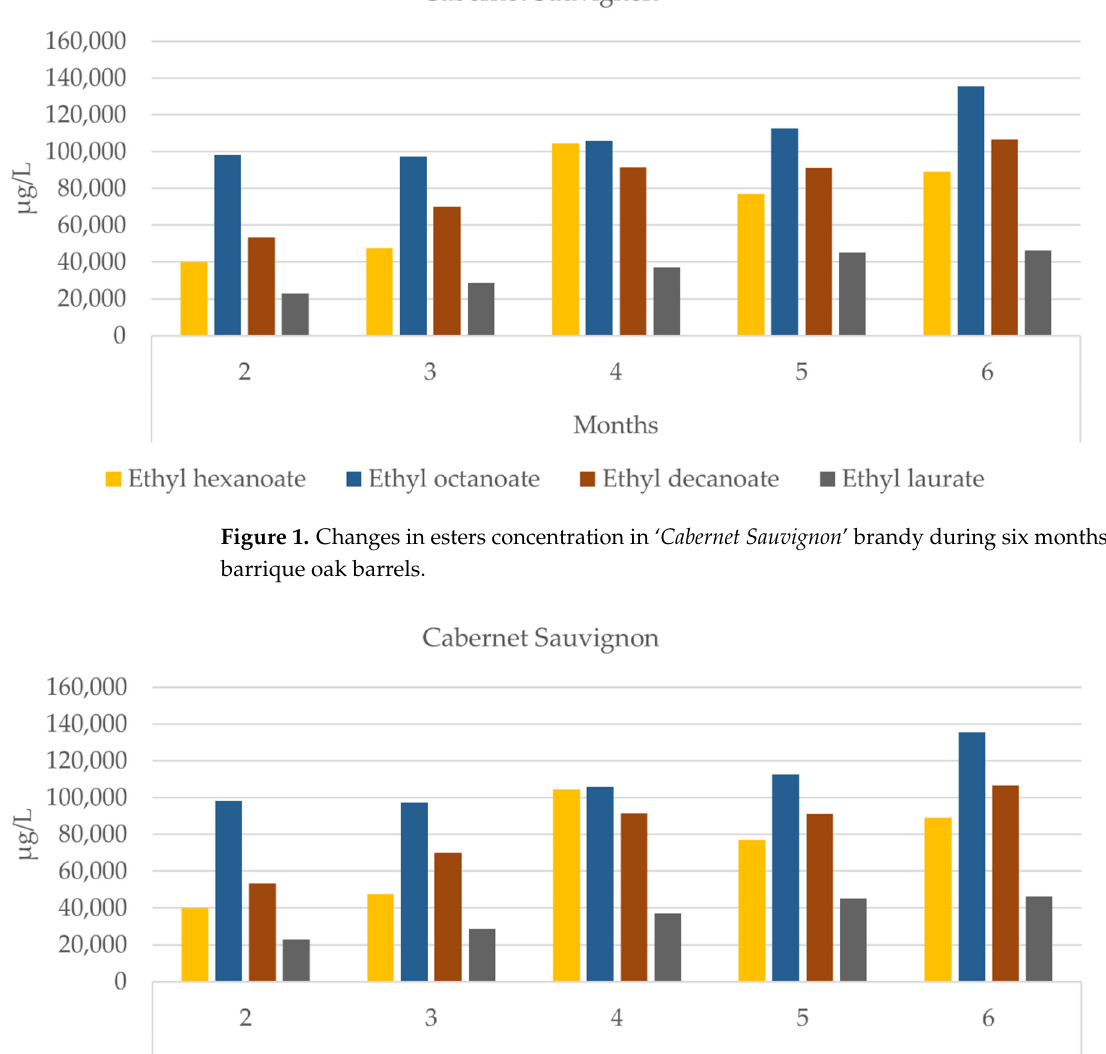
Figure 2. Changes in esters concentration in ‘ Syrah’ brandy during six month ageing in barrique oak barrels. 4. Conclusions This study provides insight into changes in volatile compounds during grape brandy production from non-typical grape varieties, ‘ Cabernet Sauvignon’ and ‘ Syrah’ . During production, some specific volatile compounds such as 2-hexenal, 3-octanone, isopropyl myristate, ethyl palmitate, ethyl oleate, phenethyl acetate, 1-hexanol, and β -damascenone could be attributed to the primary aroma generated from the grape varieties. During the vinification and fermentation process, the development of ethyl hexanoate, ethyl octanoate, 3-methylbutanol, acetic acid, and octanoic acid occurred. Finally, 3- methylbutanol and predominant esters, ethyl hexanoate, ethyl octanoate, ethyl decanoate, and ethyl laurate, were generated during the distillation and maturation process. During maturation, the content of the predominant esters increased, except in the case of ethyl octanoate in SY brandy. The composition and concentration of the determined predominant esters suggest that both brandies have volatile profiles comparable to some of the world’s most popular brandies.